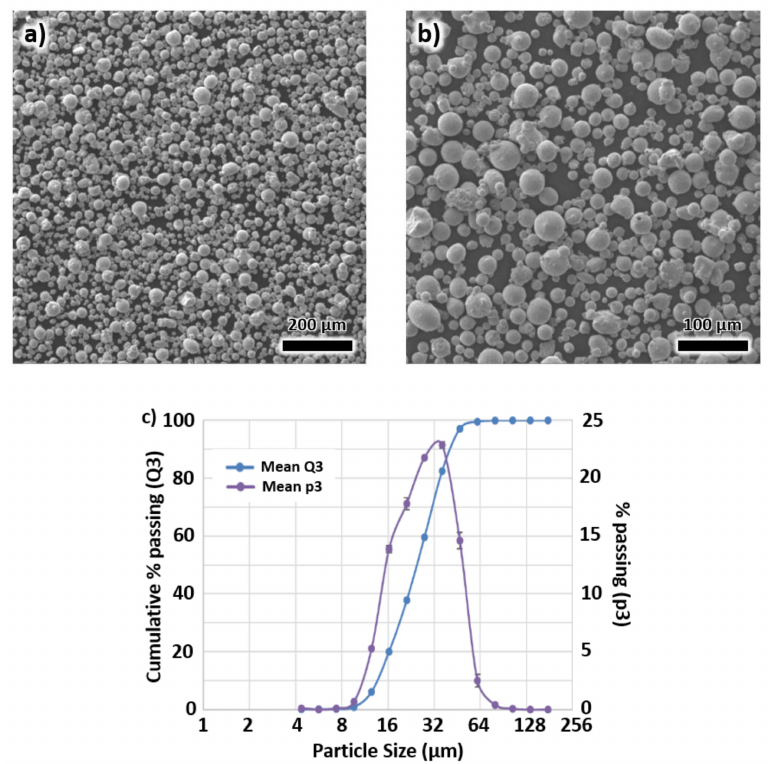
Figure 1. The scanning electron microscopy images of X3NiCoMoTi18-9-5 powders in ( a ) low and ( b ) high magnifications. ( c ) particle size distributions of the